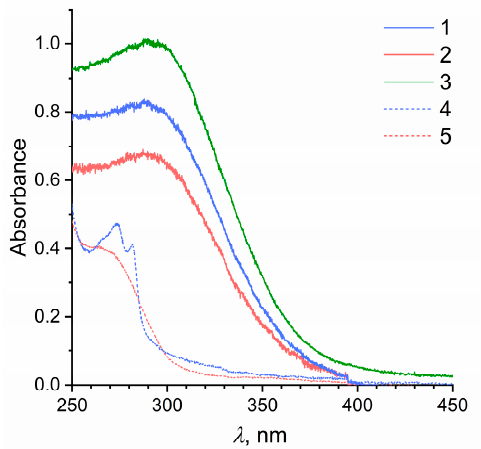
Figure 6. Optical absorption spectra of CeO 2 sols in heptane stabilized with ( 1 ) octanoic acid or ( 2 ) 2-ethylhexanoic acid; ( 3 ) CeO 2 aqueous sol. The optical absorption spectra of ( 4 ) octanoic acid and ( 5 ) 2-ethylhexanoic acid solutions are shown for comparison.